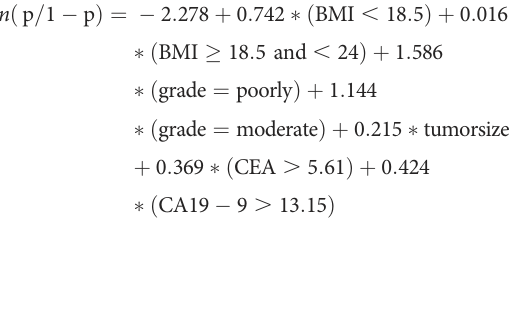
The predictive probability of LNM for each patient in the training and validation cohort was calculated. ROC curves were applied to determine the sensitivity and speci fi city of the risk factors and the model. As depicted in Figure 1A , The results show that the model demonstrated good resolution with an area under the curve (AUC) of 0.716 (95% CI: 0.683 – 0.748) in the training cohort, the AUC value of tumor size was 0.682 (95% CI: 0.647 – 0.716) which was signi fi cantly higher than other risk factors (BMI, 0.456; histological grade, 0.404; CEA, 0.549; CA19-9, 0.568). According to the ROC curve evaluation, the optimal cut-off values for the predictive probability of LNM, CEA, and CA19-9 were 0.594, 5.61 ng/ml, and 13.15 U/ml, respectively. According to the cutoff value, the training cohort was divided into low-risk ( n =